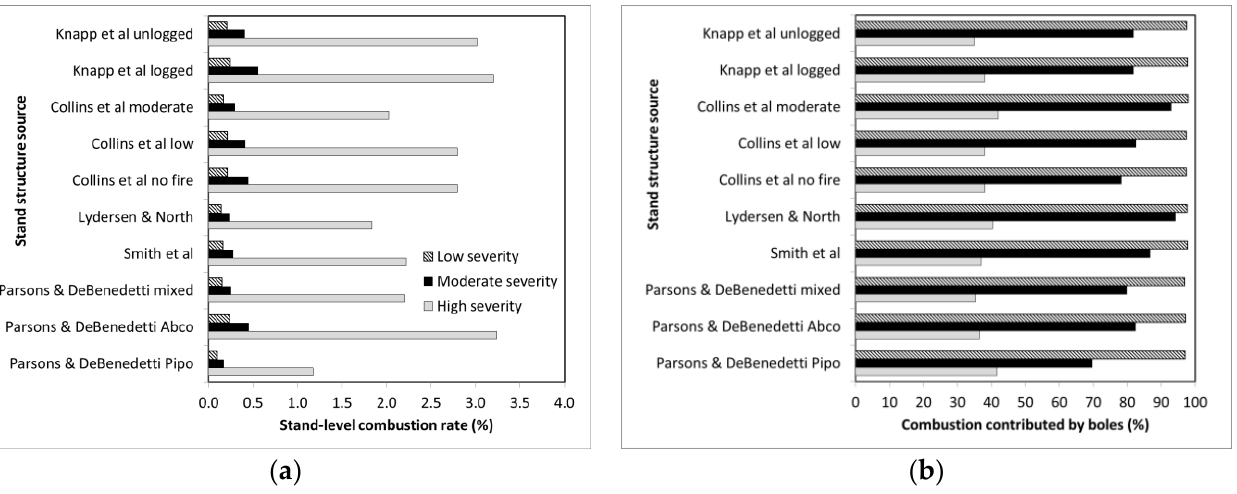
Figure 4. Stand-level combustion for published DBH size distributions for mixed conifer forests in the Sierra Nevada Mountains, California: ( a ) total combustion for high, moderate, and low severity fires; and ( b ) portion of combustion contributed by boles for high, moderate, and low severity fires. Collins et al. moderate and low severity refers to stands than had been disturbed by moderate and low severity fires in the past, respectively.